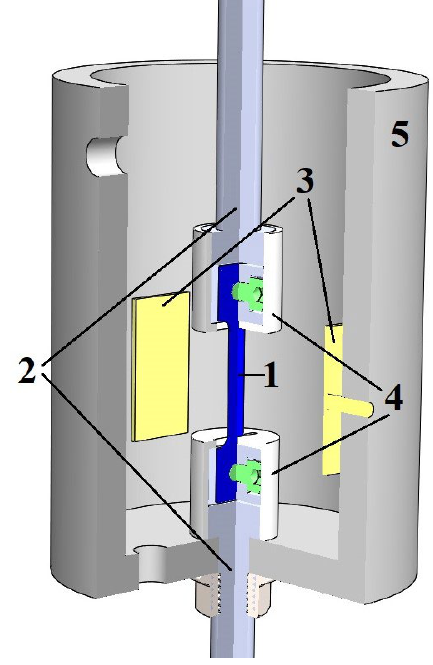
Figure 2. Schematic diagram of electrochemical cell for hydrogen charging during tensile test; (1) test specimen; (2) mechanical holders for the specimen; (3) positive electrodes; (4) electro insulating PTFE covers; (5) hermetic polypropylene enclosure for electrolyte.